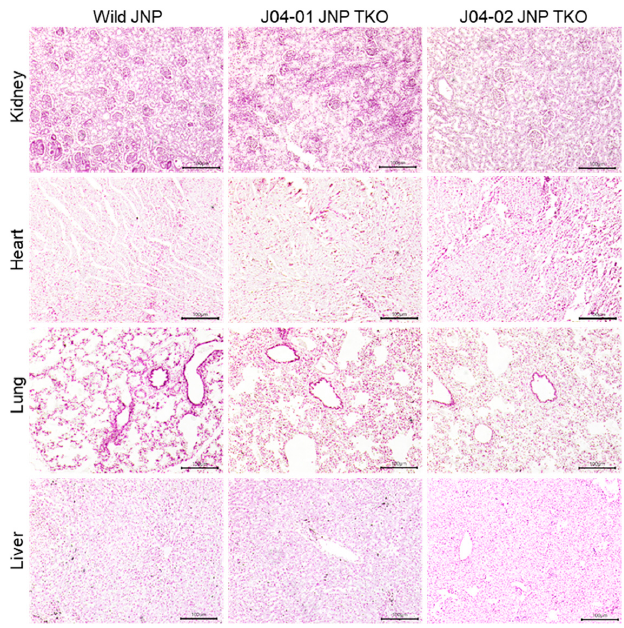
Figure 3. Histology of the primary organs of TKO JNPs. Paraffin ‐ embedded kidney, heart, lung, and liver tissues from wild ‐ type and TKO JNPs were sectioned and hematoxylin and eosin (H&E) staining was performed. Scale bar = 100 μ m.